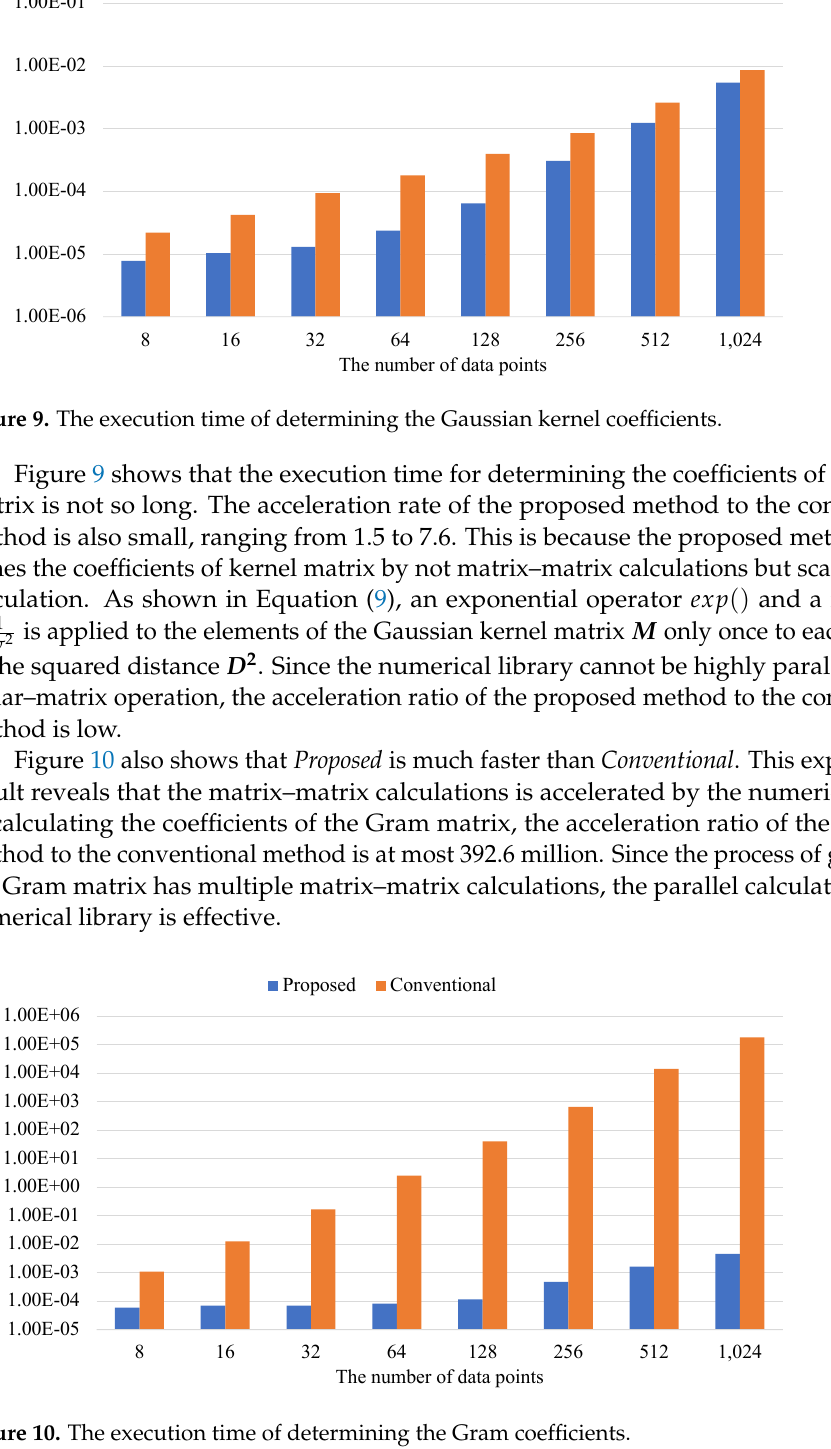
Figure 10. The execution time of determining the Gram